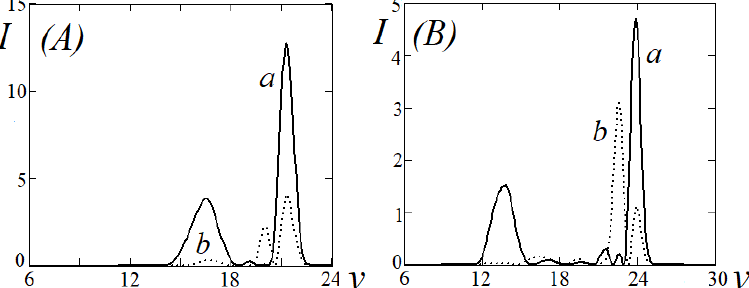
Fig. 1. The intensity of the electromagnetic pulse I =| E | 2 : (a) u =0.01; (b) u =0.1; (c) t =5.0. Fig. A – at the moment t =2.5, fig. B – at the moment t =5.0. Slice at x =15. All values in relatively units.